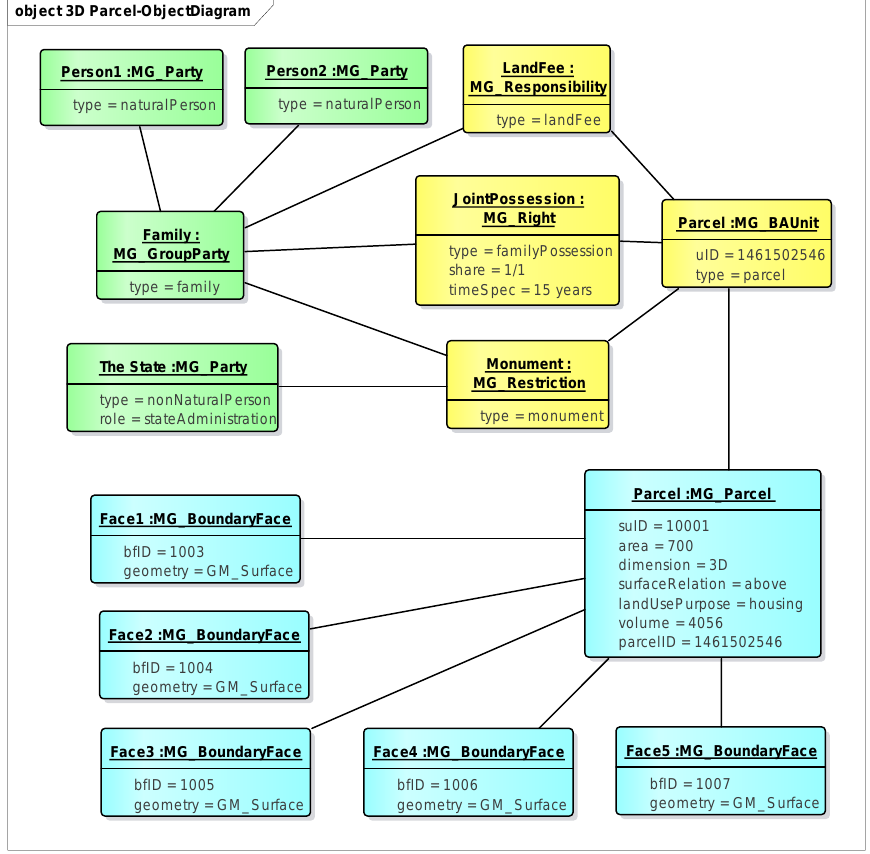
Figure 9. Instance Diagram of Party, Administrative, and Spatial Unit (3D Parcel) Package .